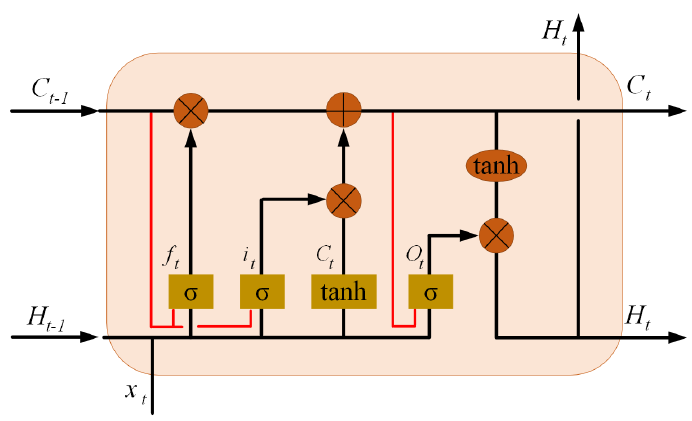
Figure 2. Inner structure of ConvLSTM